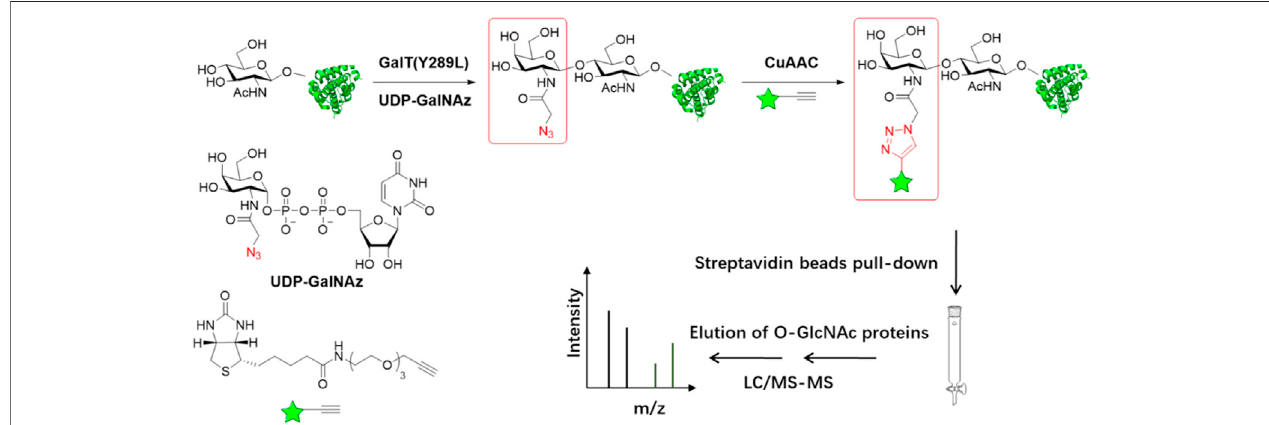
FIGURE3| SchematicofchemoenzymaticlabelingstrategyforenrichmentanddetectionofO-GlcNAcproteins.O-GlcNAcylatedproteinsincelllysatesarelabeled with azide group using β -1,4-galactosyltransferase GalT (Y289L). The biotin with the alkyne group is added to O-GlcNAcylated proteins by copper(I)-catalyzed azide- alkyne cycloaddition (CuAAC) chemistry. Following labeling with biotin, O-GlcNAcylated proteins can be captured using streptavidin resin and then simultaneously proteins are digested and analyzed by